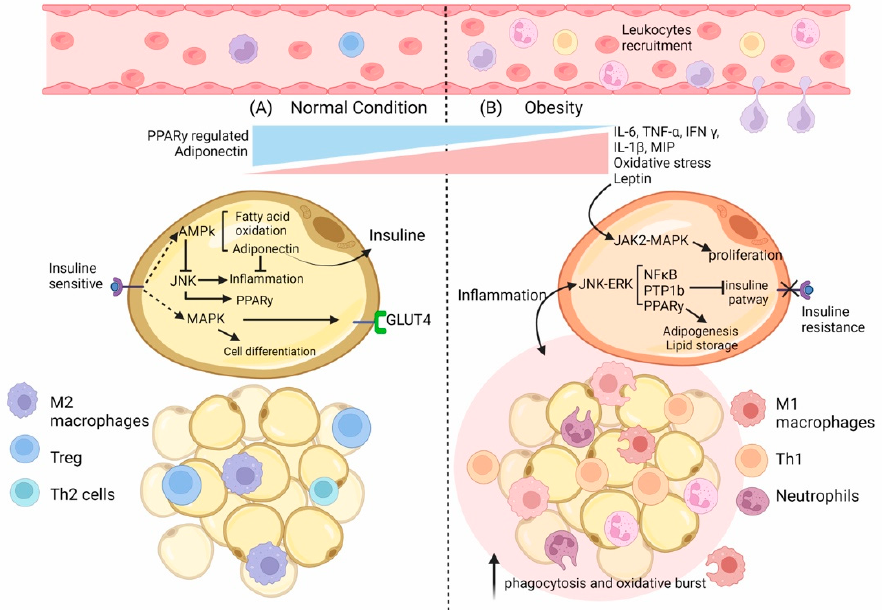
Figure 1. Environment state and adipocyte’s changes in normal vs. obese conditions. ( A ) In normal conditions in the adipose tissue (AT), M2 macrophages are distributed evenly throughout the tissue. Lean AT also contains CD4+ T cells—TH2 and Treg cells—and preadipocytes that contribute to the anti-inflammatory and insulin-sensitive state. As a result, adipokines such as adiponectin are increased, whereas leptin content is decreased. In adipocytes, the regulation of differentiation and proliferation occurs by activating the insulin receptor (IR), which also controls the incorporation of glucose. Moreover, IR regulates the activation of AMPK in an energy state-dependent manner, promoting β -oxidation and adiponectin expression, resulting in the control of inflammation. ( B ) In obese AT, specific immune cells such as macrophages increase their number by local proliferation and contribute to secreting pro-inflammatory cytokines and ROS. In addition, the content of other immune cells also changes with an increase in Neutrophils, CD4+ Th1, and CD8+ T cell numbers, a reduction in Treg cell as well as an increase in the number of preadipocytes. As a result, the production of pro-inflammatory adipokines such as TNF- α , IL-6, IL-1 β , and MCP1 increases; consequently, there is an increased immune cell infiltration and a polarization of the phenotype. Furthermore, in adipocytes, the augmented inflammatory state disrupts the regulation of signaling pathways such as JNK-ERK, which involves the inhibition of the IR by PTPB1, the up-regulation of PPAR- γ , and the synthesis of lipids as well as of the inflammatory NFkB pathway, which is also enhanced by overexpressed Leptin in an obese